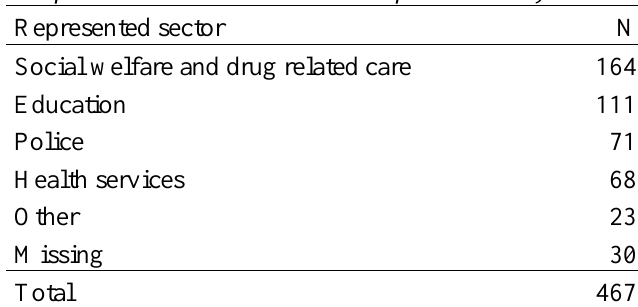
Sample Characteristics—Sector Representation, N = 467 Represented